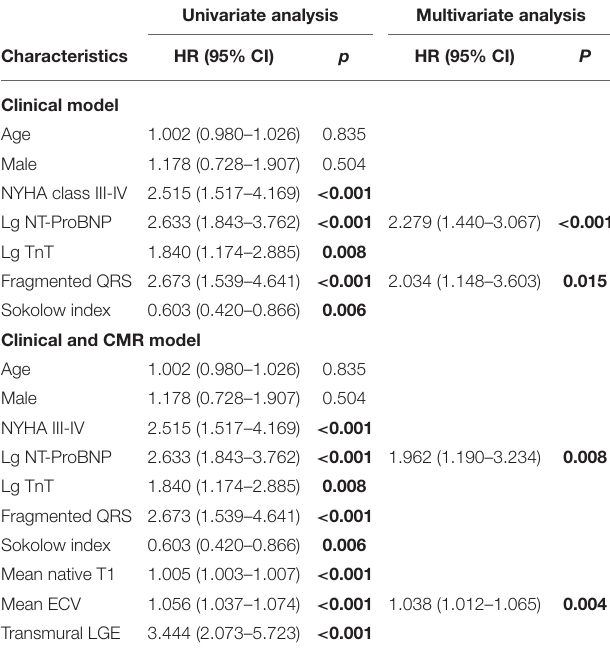
TABLE 4 | Cox proportional hazard multivariable models to define the independent impact of ECG characteristics on survival. Univariate analysis Multivariate analysis